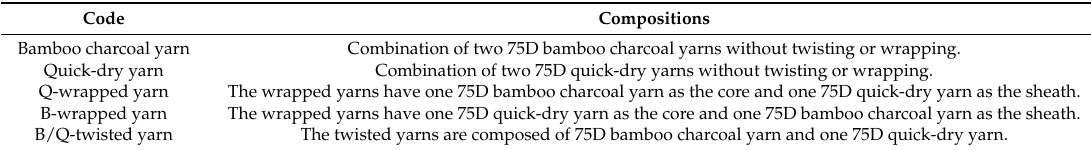
Table 1. Composition of functional composite yarns. Q: Quick-dry, B: Bamboo charcoal, and D: Denier. Code Compositions Bamboo charcoal yarn